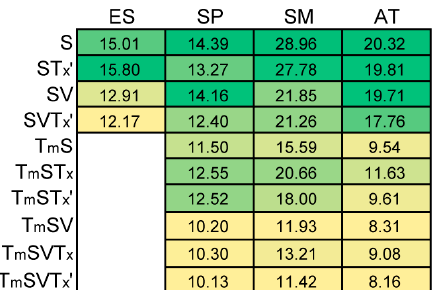
Figure 5. Image segmentation at two scale levels and with two shape parameters: ( a ) Standard false color composites (band rank: near-infrared, red, and green) of GF-1 WFV layer stack imagery; ( b ) Segmentation at scale value of 10 and shape parameter value of 0.1; ( c ) Segmentation at scale value of 30 and shape parameter value of 0.1; ( d ) Segmentation at scale value of 30 and shape parameter value of 0.9; ( e ) Box plot depicting local variance (LV) against the different shape parameter settings at a scale value of 30 of the multiresolution segmentation algorithm.